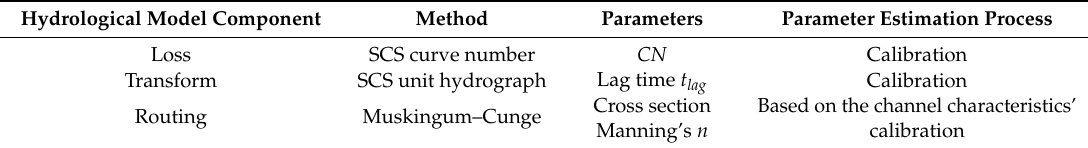
Table 1. HEC-HMS model components, methods and parameters. SCS: Soil Conservation Service; CN : curve number.